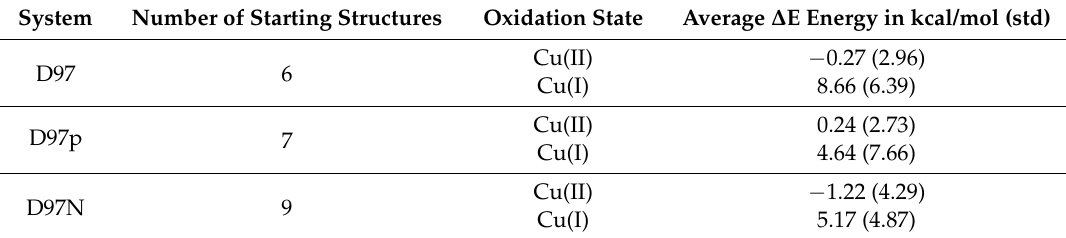
Table 4. Average energy difference ∆ E = E top-hat − E N-bound and standard deviation in kcal/mol for NO 2 − binding in D97, D97p and